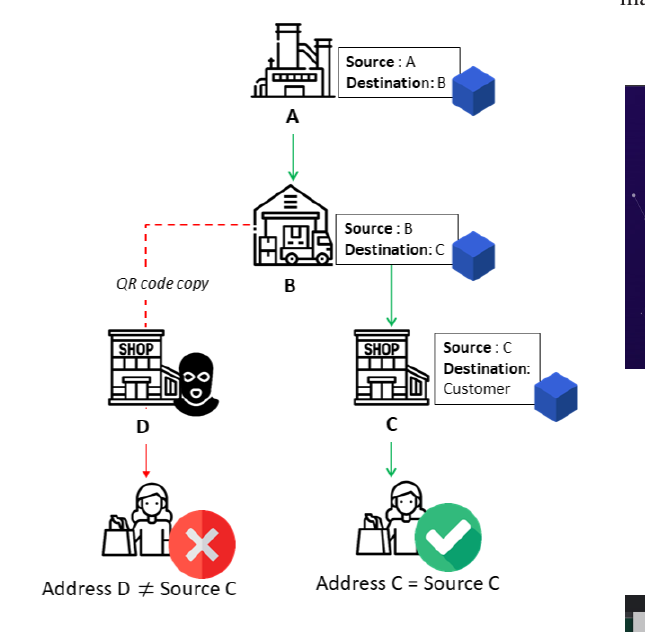
Figure 5: Dealing with Counterfeit Product.